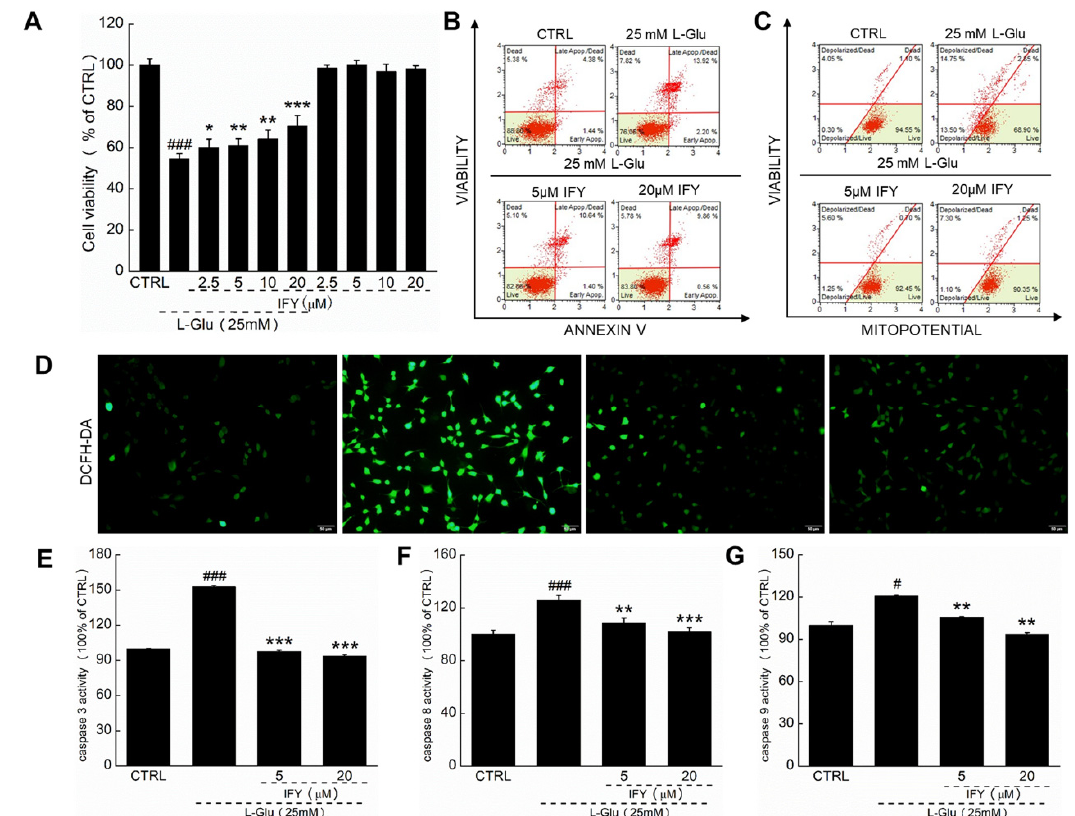
Figure 1. Isoforsythiaside (IFY) resisted apoptosis in HT22 cells induced by L-glutamate (L-Glu). ( A ) IFY improved the cell viability of HT22 cells exposed to L-Glu. Simultaneously, IFY showed no toxicity cultured with HT22 cells alone ( n = 6). ( B ) IFY prevented L-Glu-induced HT22 cell apoptosis ( n = 6). ( C ) IFY relieved the mitochondrial membrane potential (MMP) imbalance in L-Glu-damaged HT22 cells ( n = 6). ( D ) IFY ameliorated the overaccumulation of reactive oxygen species (ROS) in HT22 cells damaged by L-Glu (magnification × 20, scale bar: 50 µ m ( n = 6)). IFY reduced the expression of ( E ) caspase-3 ( n = 6), ( F ) caspase-8 ( n = 6) and ( G ) caspase-9 ( n = 6) in HT22 cells exposed to L-Glu. Data are shown as the mean ± standard error (SEM). # p < 0.05, ### p < 0.001 vs. CTRL, * p < 0.05, ** p < 0.01, *** p < 0.001 vs. L-Glu-exposed HT22